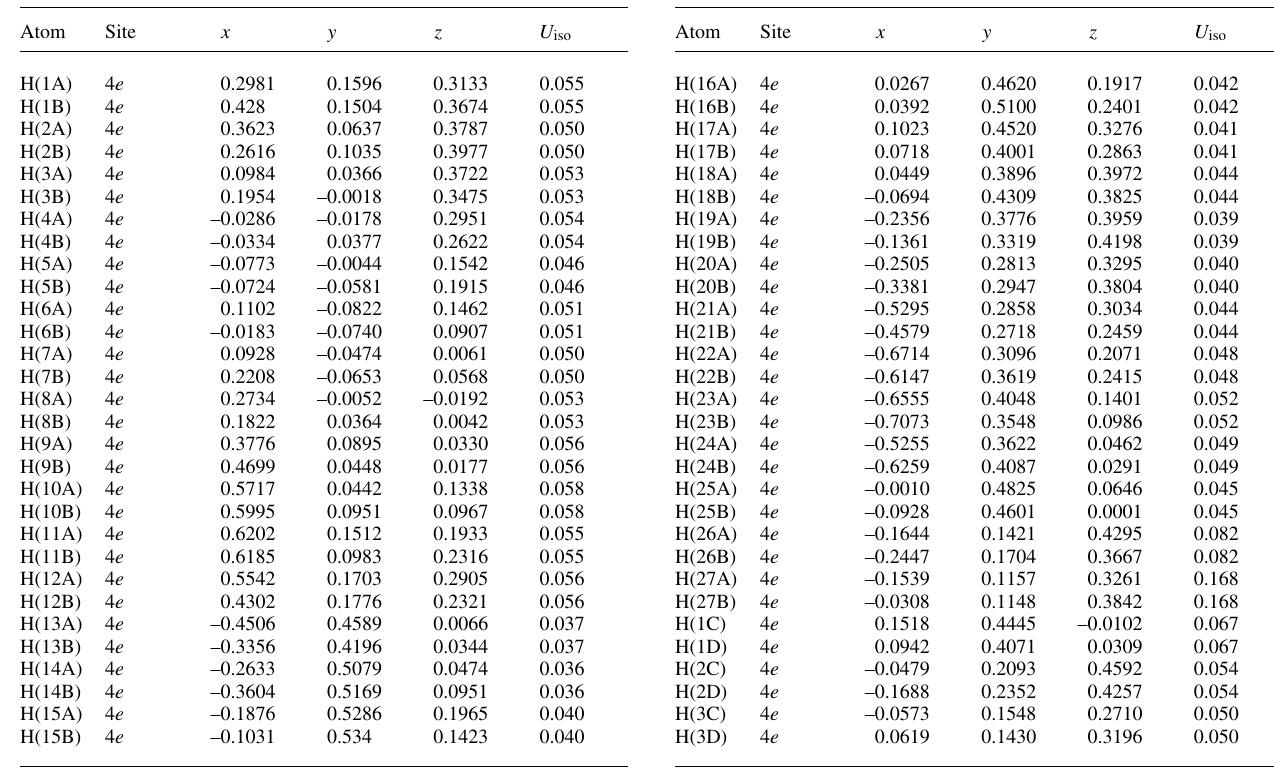
Table 2. Atomic coordinates and displacement parameters (in Å 2 )